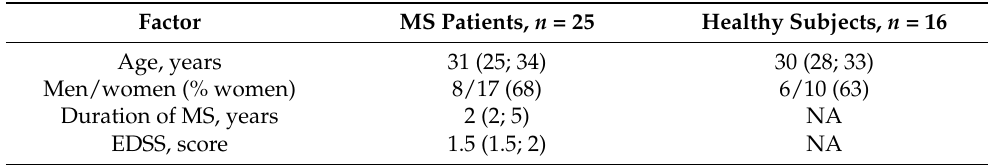
Table 4. Clinical and demographic characteristics of MS patients and healthy subjects. Data are medians (25th and 75th percentiles). Factor MS Patients, n = 25 Healthy Subjects, n = 16 Age, years 31 (25;